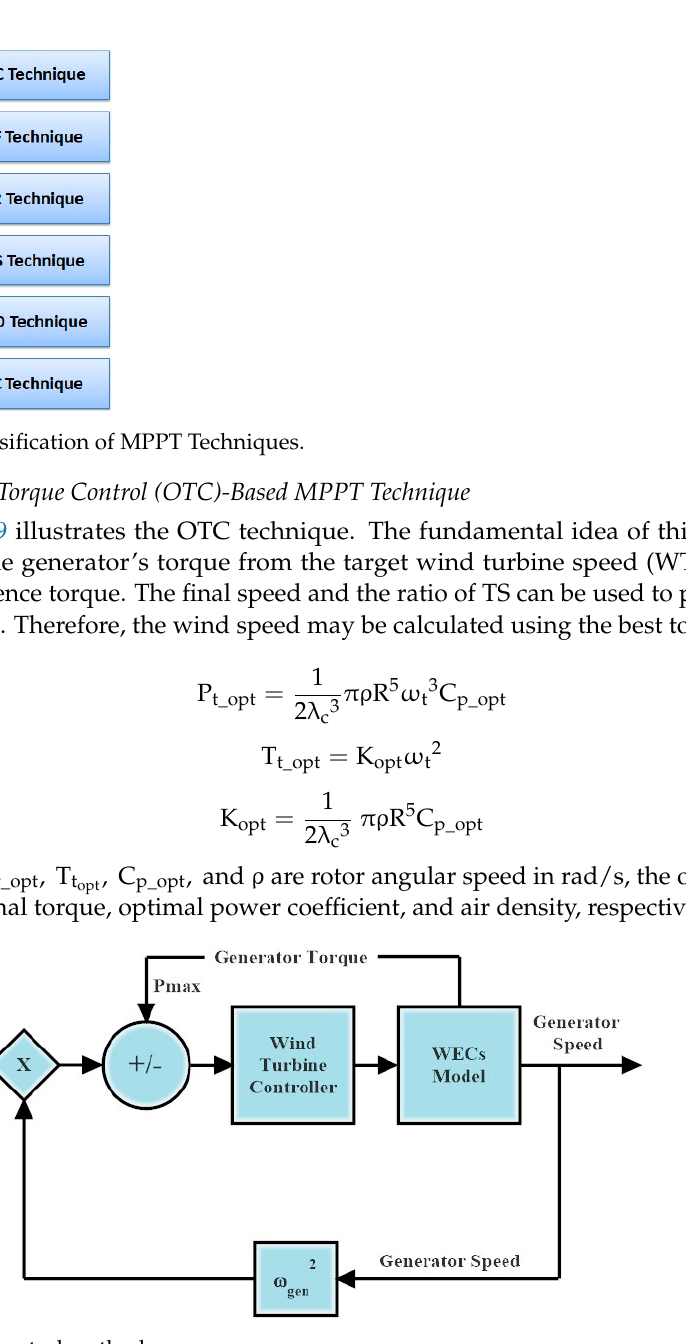
Figure 9. OT control method.